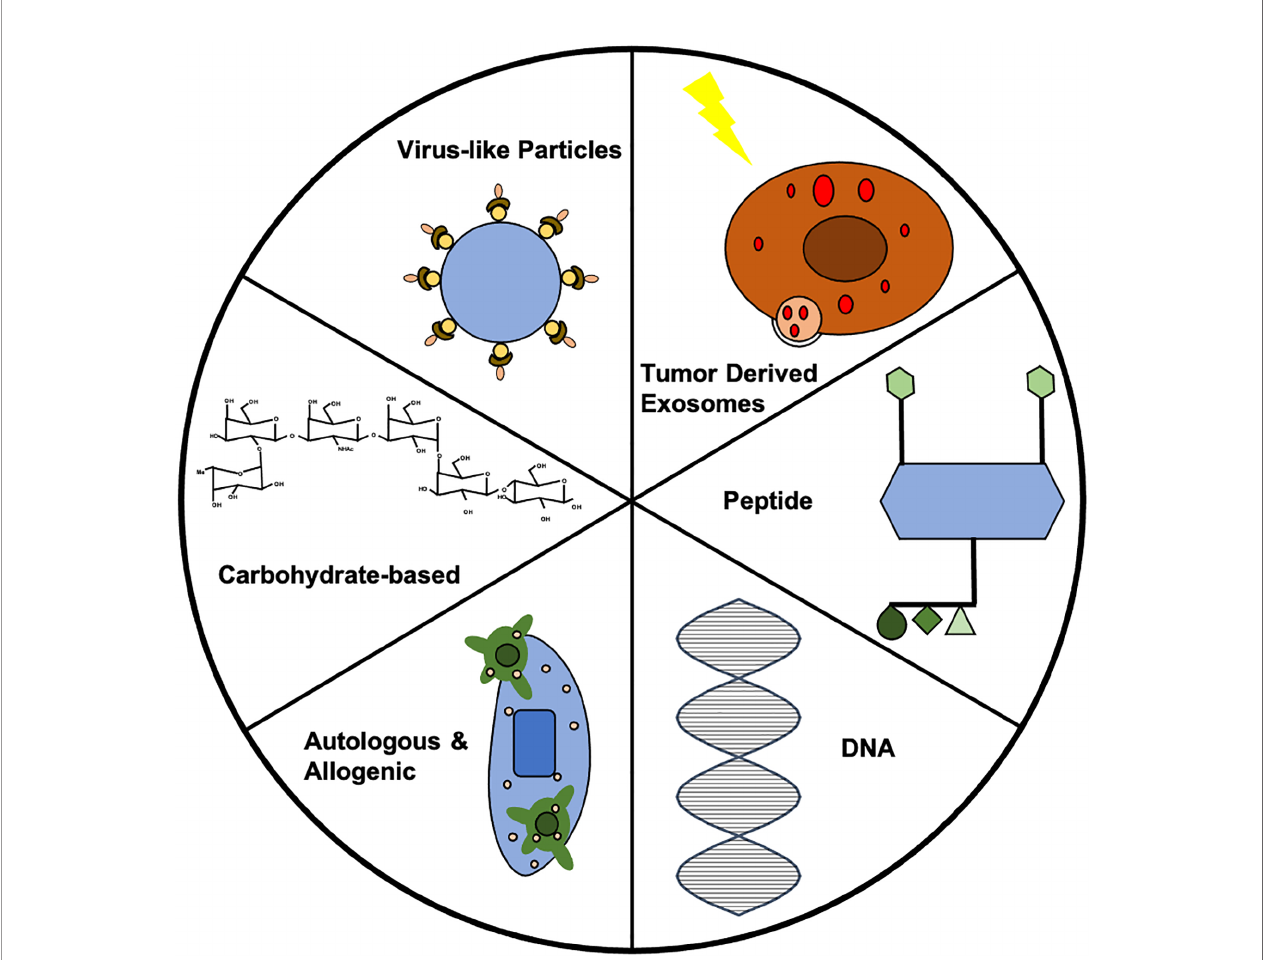
FIGURE 1 | Summary of vaccine strategies. Each vaccine strategy has potential for use in prophylactic cancer vaccines. Further investigation into each strategy could lead to clinically-relevant prophylactic cancer vaccines. In this fi gure, the VLP represents the HER2-VLP, which has elevated levels of anti-HER2 antibody to protect against breast cancer. The carbohydrate displayed is the chemical structure of Globo H, which has often been used in therapeutic vaccines, but shows potential for prophylactic vaccine development. The allogenic vaccine displays dendritic cells (DCs) recognizing the tumor antigen, which can allow for immune cell activation. The double helix of DNA is the building block for all DNA vaccines. The peptide vaccine shows four epitopes engineered for display, which caused upregulation of CD4+ and CD8+ T cells in addition to increases in IgG antibodies in vaccinated mice. The exosome shows TEX synthesis via radiotherapy that prevented breast cancer via